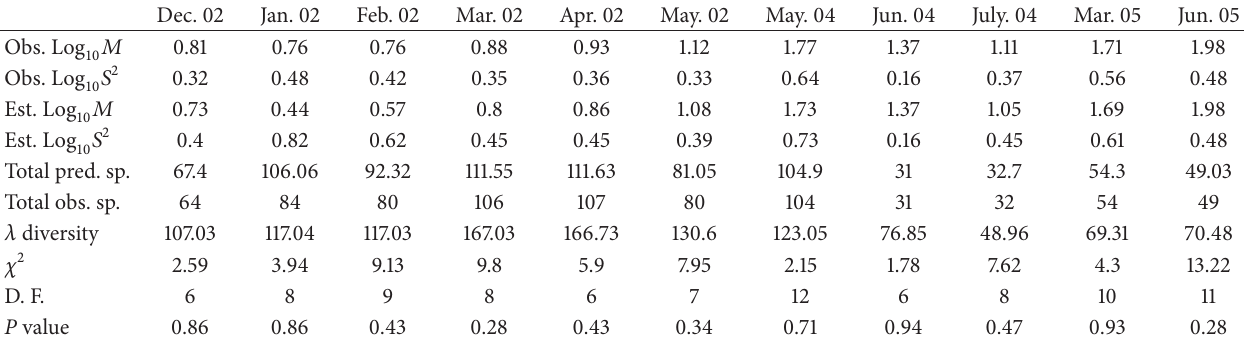
Table 3: Results obtained when fitting the log normal distribution to our data and results of the chi-squared tests of the observed and expected observations.